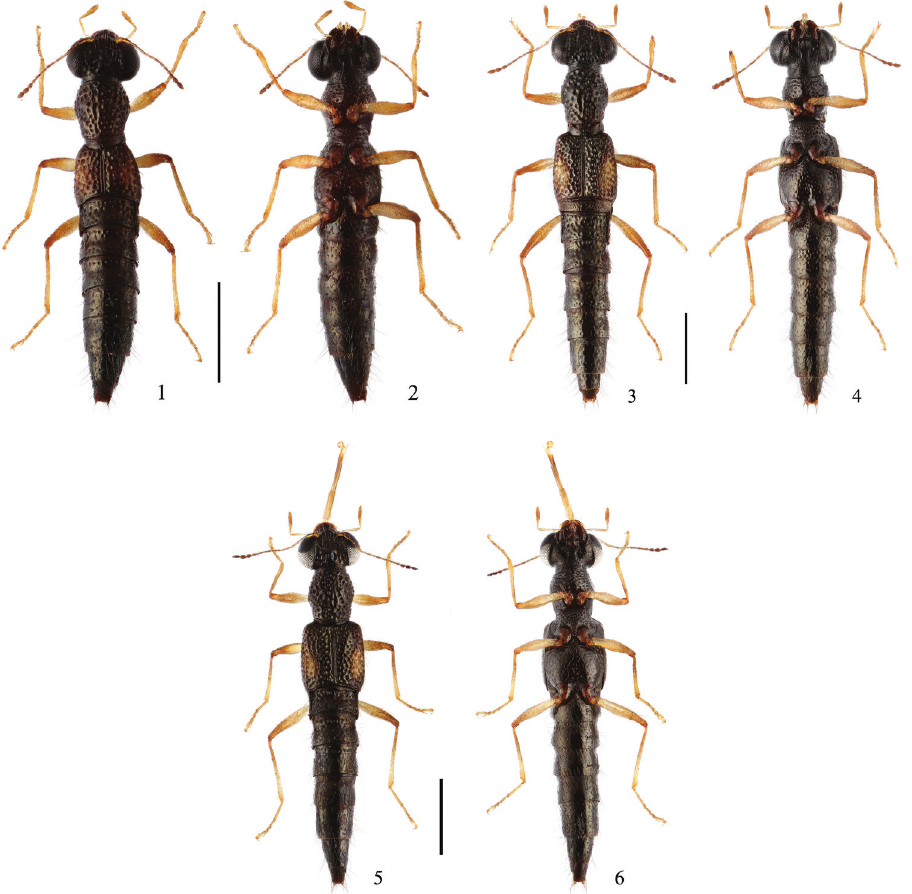
Figures 1–6. Habitus. 1, 2 Stenus dashaheensis sp. n. 3, 4 Stenus zhangyuqingi sp. n . 5, 6 Stenus liuyixiaoi sp. n. Scale bars: 1